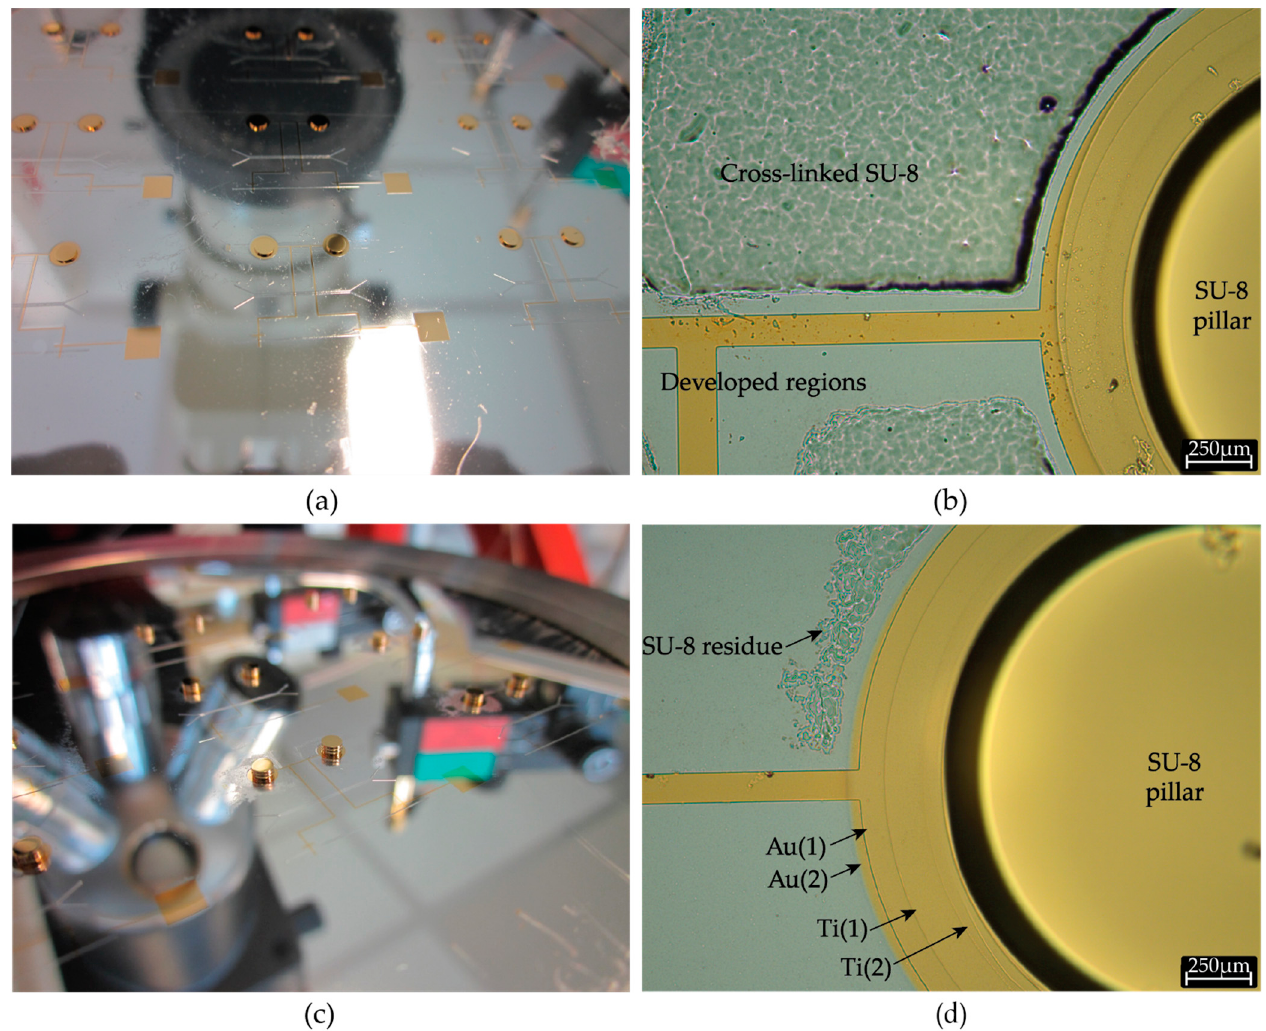
Figure 4. ( a ) Silicon wafer after metallization of 300µm SU-8 pillars. In this case, no sacrificial resist layer was used prior to SU-8 lithography leading to a thin glossy coating of cross-linked SU-8. ( b ) Optical micrograph of the wafer in Figure 4a, showing unexposed yet cross-linked SU-8 regions resisting overnight development in PGMEA. ( c ) Silicon wafer after metallization of 1mm SU-8 pillars (resulting from stacking of three SU-8 layers). AZ 10XT was used as sacrificial layer, resulting in vastly cleaner surface after development. ( d ) Optical micrograph of the wafer in Figure 4c, showing the region around the SU-8 pillar. Metallic stack consisting of a sandwich (Ti(1)/Au(1)/Ti(2)/Au(2)) of titanium adhesion and gold electrode layers is also visible.